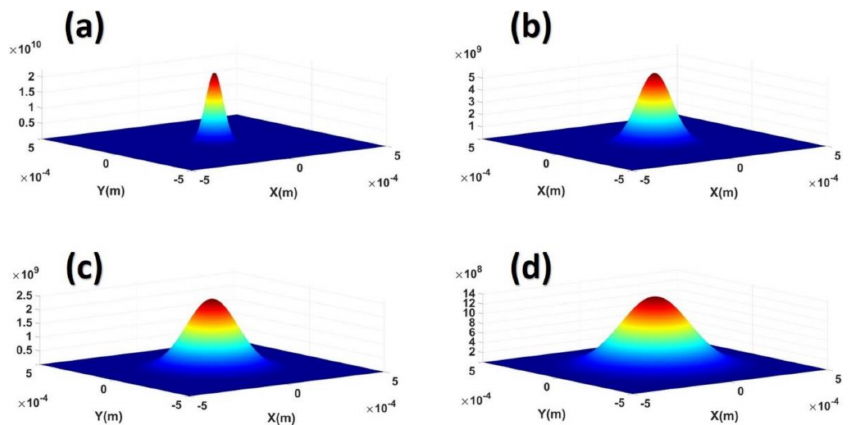
Figure 7. Gaussian distribution of the heat source for laser spot diameters of ( a ) 50 µ m, ( b ) 100 µ m, ( c ) 150 µ m, and ( d ) 200 µ m. Table 6 denotes the equations of the second-order fitted curves of the laser spot diameter–temperature